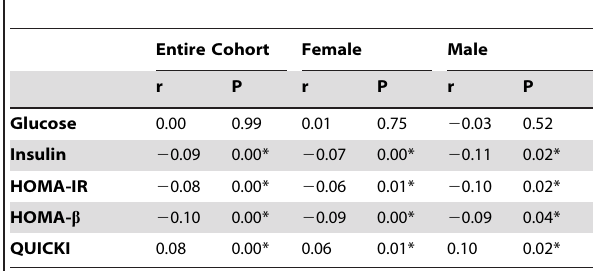
Table 4. Partial correlation analyses of ghrelin with physical and biomedical characteristics regarding menopausal